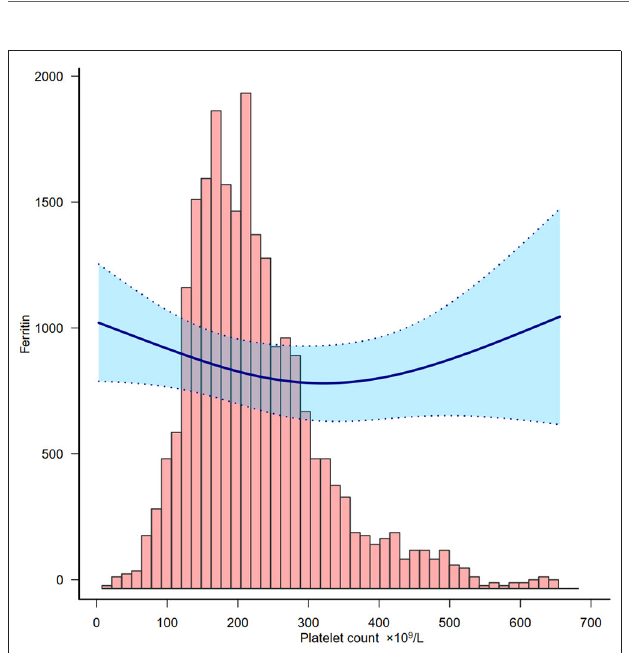
FIGURE 3 | Relationship between platelet count and ferritin. Adjusted for all covariates in Table 2 except